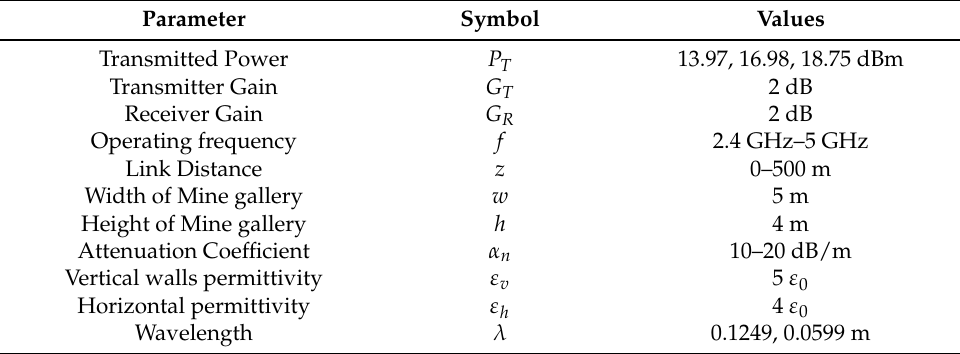
Table 2. Particular and associate values used for